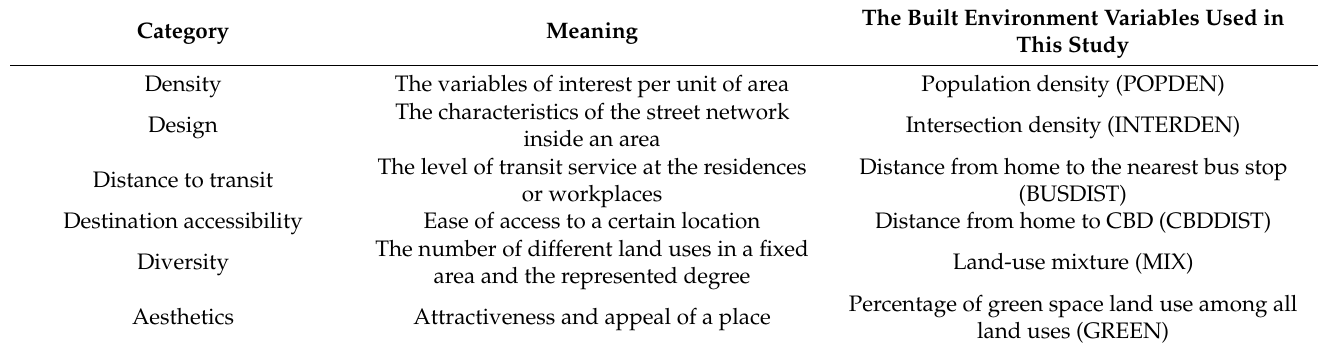
Table 2. The description of built environment